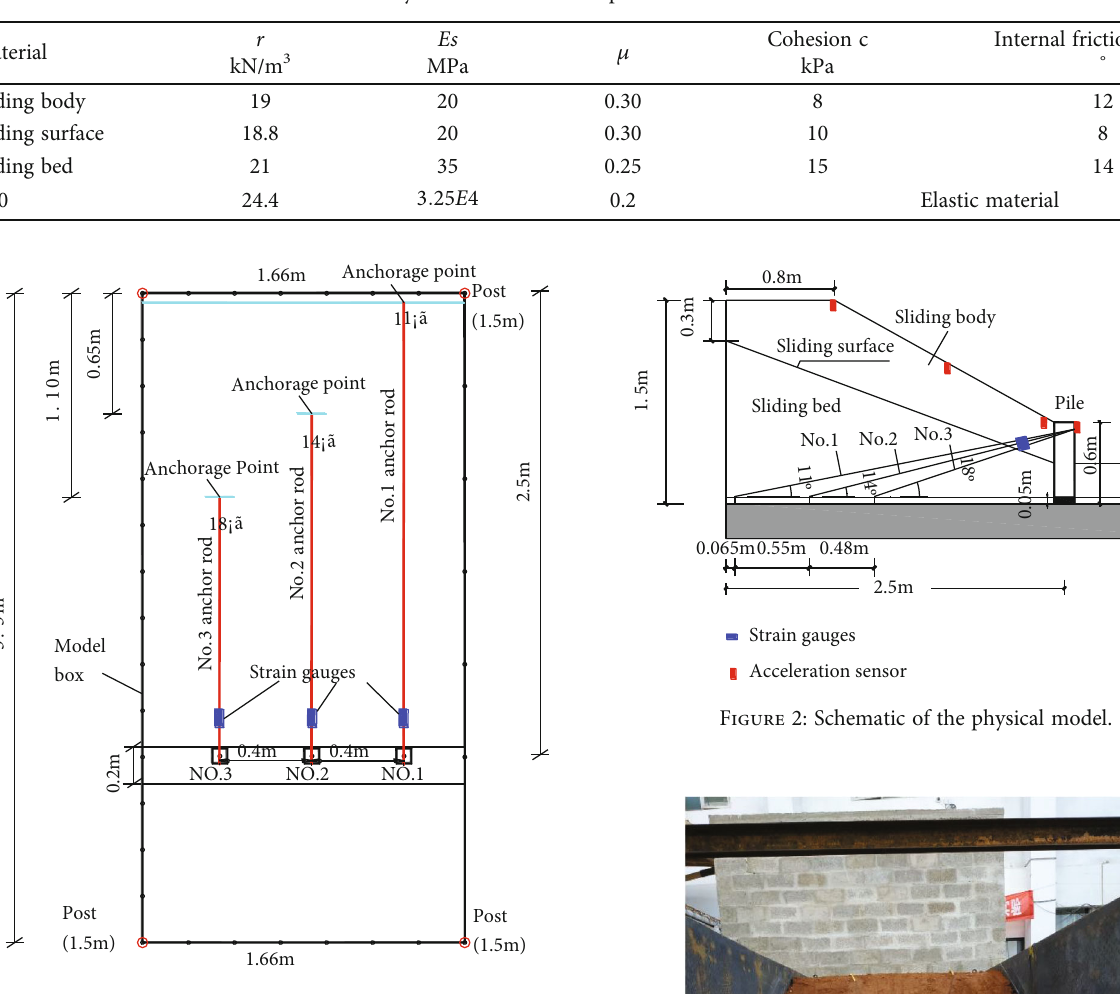
Figure 1: Top view of the physical